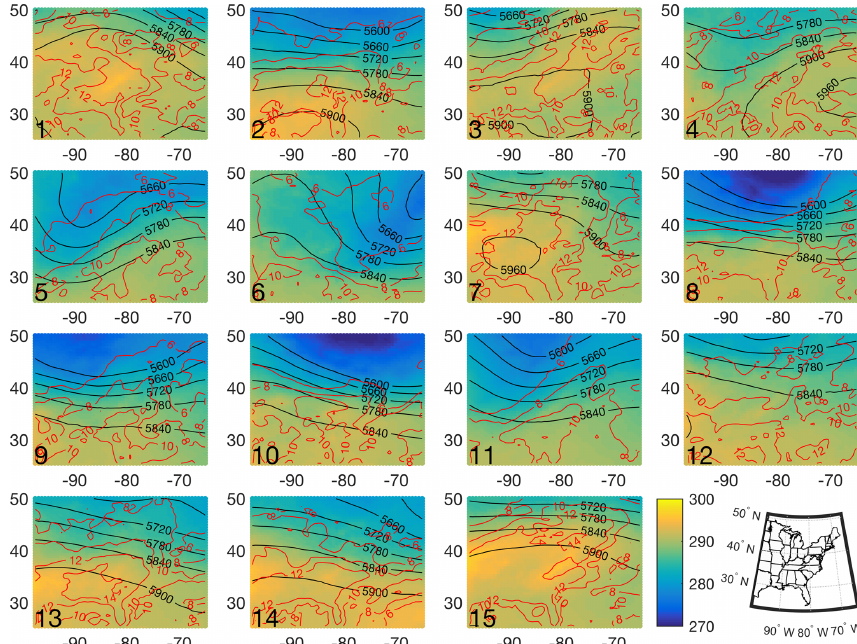
Figure 2. Summary of the conditions under each of the PCA-derived synoptic modes of variability. The panels show the “mode centroid” (i.e., mean of the 7 days that exhibit highest PC scores for the type). The color depicts T 850 (K), the solid black lines show Z 500 (gpm: geopotential meters) and the red lines depict q 850 (gkg − 1 ). The PC number is shown in the lower left of each panel and the panels are arranged so that the first mode of variability is shown in the upper left panel, the fifth PC is shown in the second row in the left-most panel and so forth. To aid legibility, the panels in this figure denote the study region as a rectangle, with state outlines excluded, thus also shown in the lower right of this figure is a map depicting the state outlines for the same domain as shown in the other panels but using a plate carrée projection (i.e., the equirectangular projection) used in Figs. 1, 4–7.